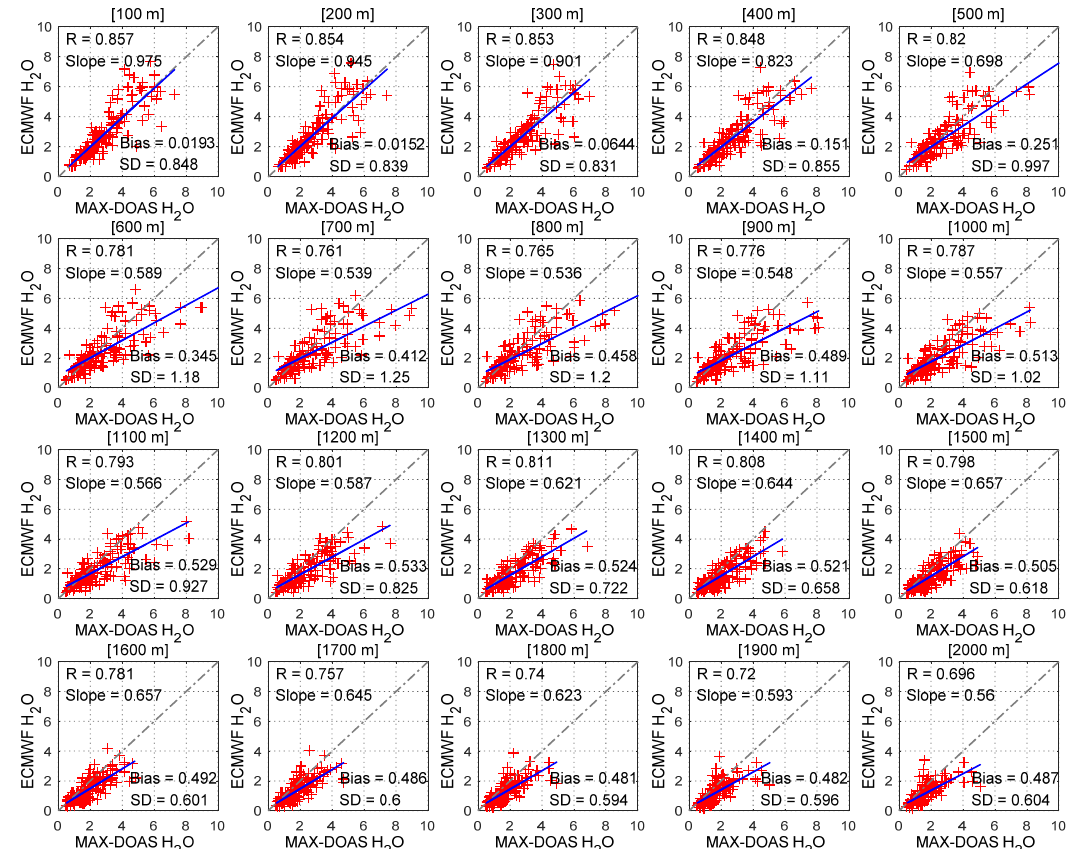
Figure 9. Correlation analysis of MAX-DOAS water vapor concentrations and ECMWF results in di ff erent the MAX-DOAS grid using a linear method to facilitate vertical layers. The 00:00 and 06:00 UTC ECMWF profiles are interpolated onto the comparison. Both the MAX-DOAS and ECMWF profiles are normalized to the AERONET timetable for cloud screening. The Pearson correlation coe ffi cient (R), linear fitting slope (Slope), the bias with stand deviation (SD) between MAX-DOAS and ECMWF result at each layer are given in this figure. All values here are in units of 10 17 molec / cm 2 . Good agreement between the MAX-DOAS and ECMWF results can be observed in height layers below 2000 m, with the Pearson correlation coe ffi cient (R) ranging from 0.695 to 0.857. Under an increase in layer height, the detection sensitivity of MAX-DOAS gradually decreases and the correlation analysis results degrade. In the layer height from 600 to 1200 m, the consistency between the MAX-DOAS concentrations and the ECMWF results is slightly worse, which may be the result of the large uncertainties in these layers. The decreasing detection sensitivity and the enhanced constraint of a priori profile together lead to the decreasing linear fitting slope with increasing height. MAX-DOAS results have high sensitivities in the lower atmosphere and the contribution of a priori profile in retrieved profile is relatively small. With the increasing height, the detection sensitivity gets worse and the dependence of retrieved profile in a priori profile becomes strong gradually. The fixed exponentially decreasing a priori profile with a surface concentration of 4.6 × 10 17 molec / cm 3 and a scale height of 1.9 km may be too high to represent the water vapor concentrations in high altitudes. Together with the low sensitivity in high altitudes, the retrieved concentrations in high altitudes can be higher than actual situation, thus the linear fitting slope decreases and the bias between MAX-DOAS and ECMWF increases, as shown in Figure